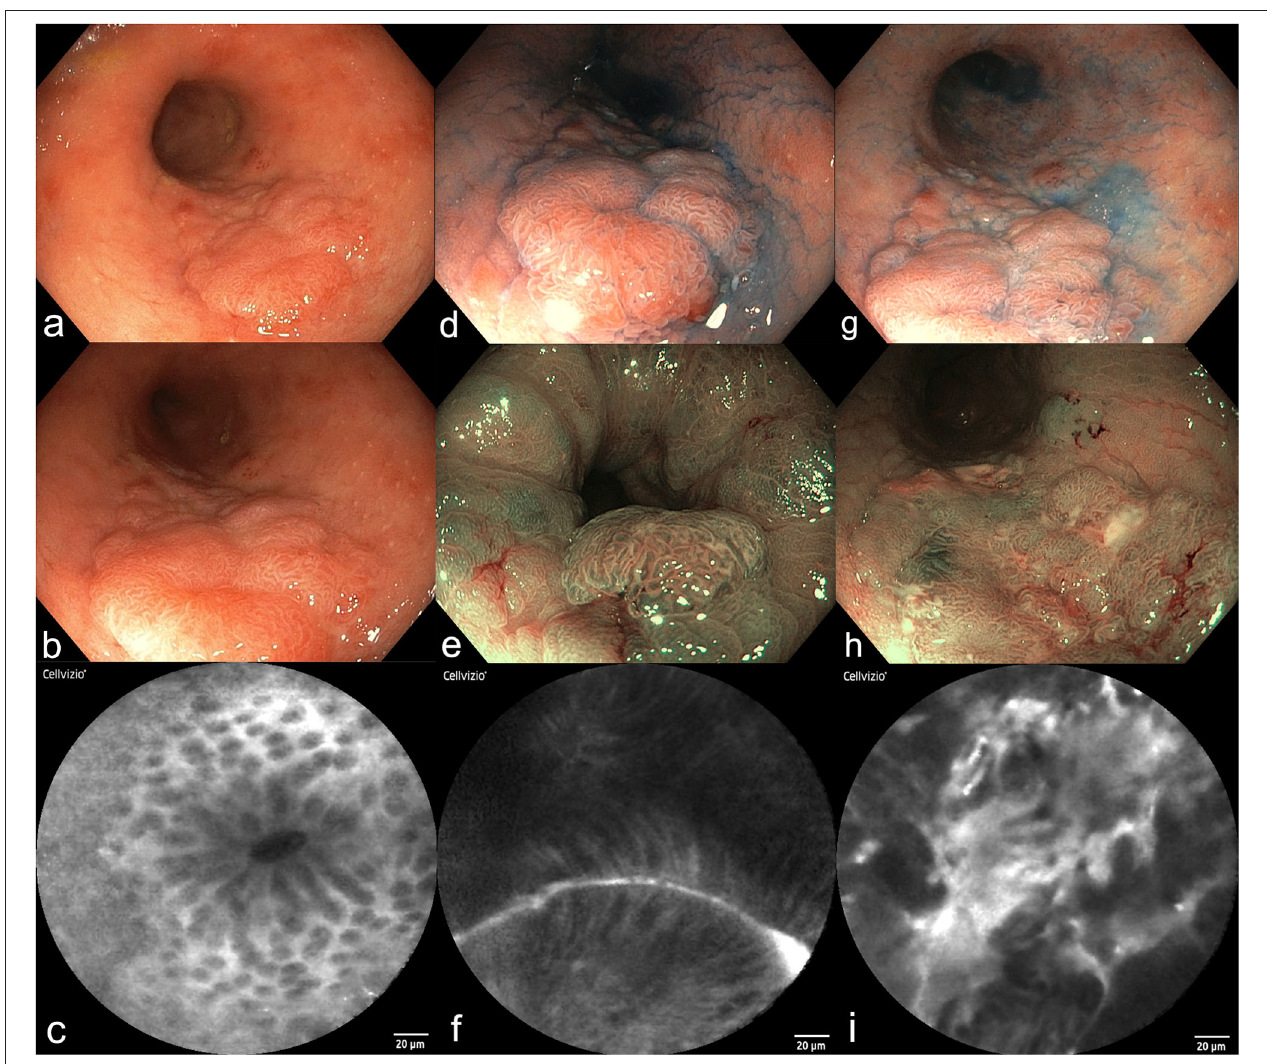
FIGURE 1 | Surveillance colonoscopy in a female patient (64y) with a history of UC for 15 years (a–i) . (a,b) High-resolution video endoscopy shows a flat polypoid lesion in the sigmoid colon, size 4 × 2cm, Paris Classification IIa + c. (c) Probe-based confocal laser endomicroscopy of the surrounding mucosa revealed mild inflammation and normal crypts. (d–f) Dye-based chromoendoscopy with indigocarmine (d) , narrow-band imaging [NBI, (e) ], and pCLE (f) of the distal border of the polyp. A tubular structure and distorted mucosal epithelial cells become visible. (g–i) Dye-based chromoendoscopy with indigocarmine (g) , NBI (h) , and pCLE (i) of the proximal part of the polyp. (i) Shows high-grade intraepithelial neoplasia. Final histology of this lesion after proctocolectomy revealed well-differentiated intramucosal cancer without